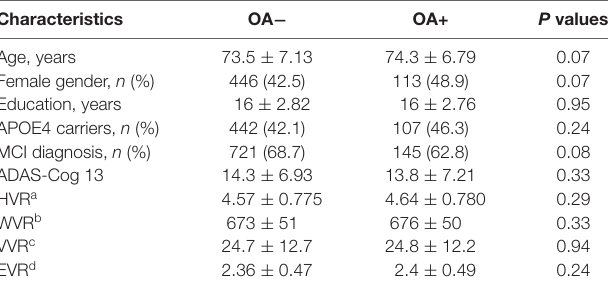
TABLE 1 | Demographics and clinical characteristics by OA status. Characteristics